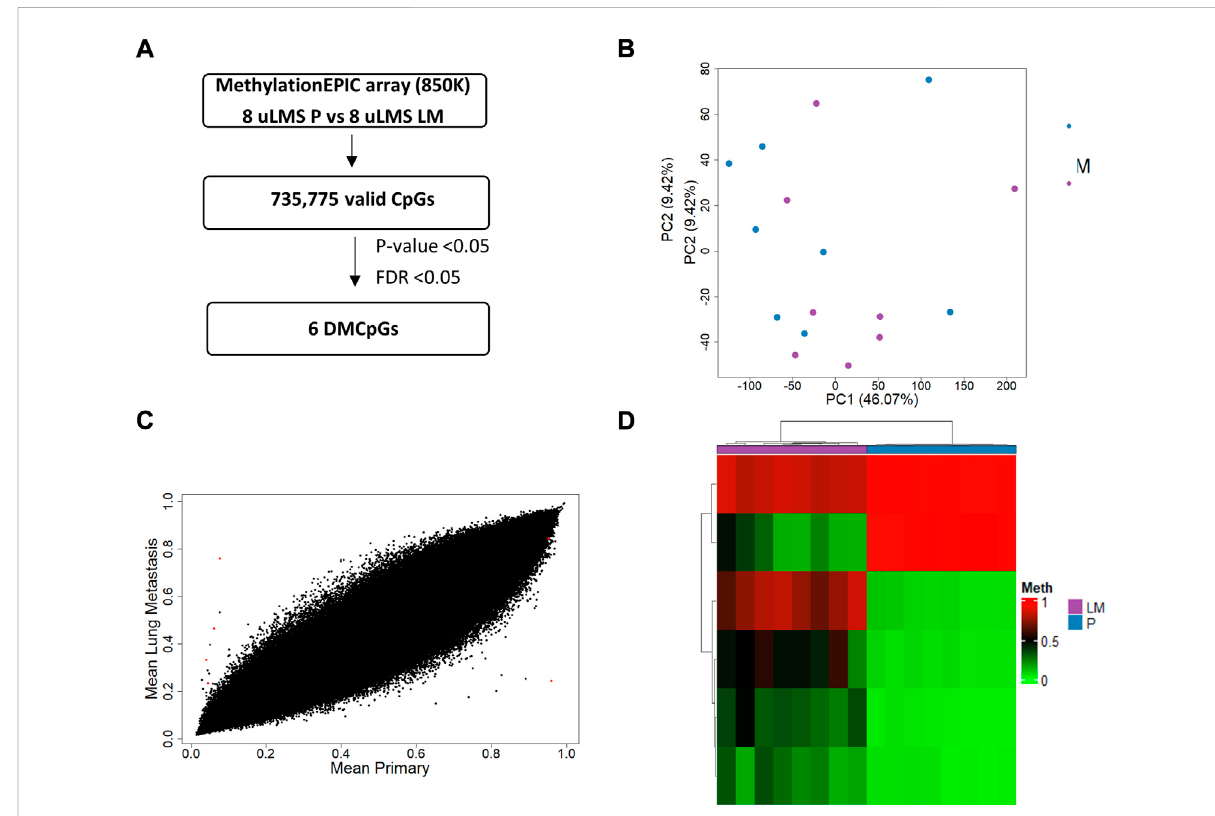
FIGURE 7 Genome-wide DNA methylation analysis of the ITF in paired tumors of uLMS patients. (A) Schematic fl owchart used to identify signi fi cant differentially methylated CpGs at the ITF. (B) Principal component analysis (PCA) of DNA methylation data at the ITF. (C) Scatter plot representing mean normalized levels of DNA methylation ( β -values) at the ITF of primary tumors and lung metastasis. Dots in red show signi fi cant differentially methylatedCpGs. (D) Hierarchical clustering ofthesixdifferentiallymethylatedCpGs(FDR < 5%)foundattheITFofprimaryandlungmetastasis of uLMS patients. DMCpGs, differentially methylated CpGs; Meth, DNA methylation; P, Primary tumors; LM, lung metastasis; uADC, uterine adenocarcinomas; uLMS, uterine